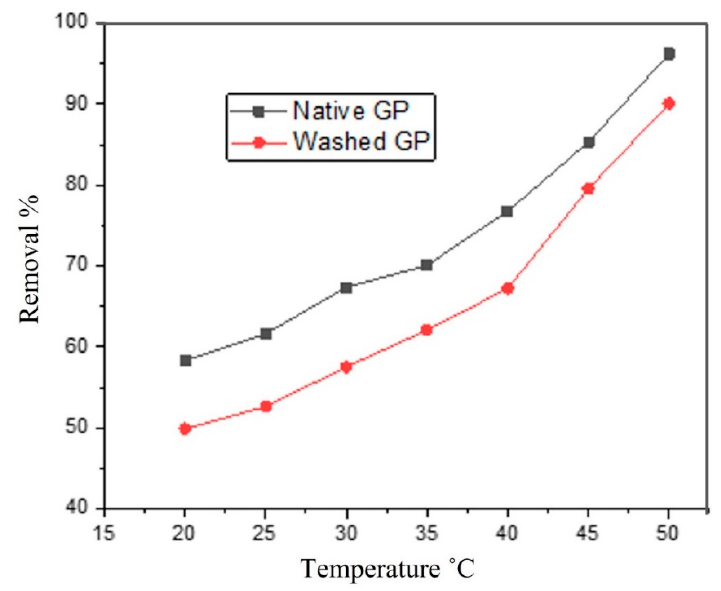
Figure 6. Effect of temperature on the removal of EBT.